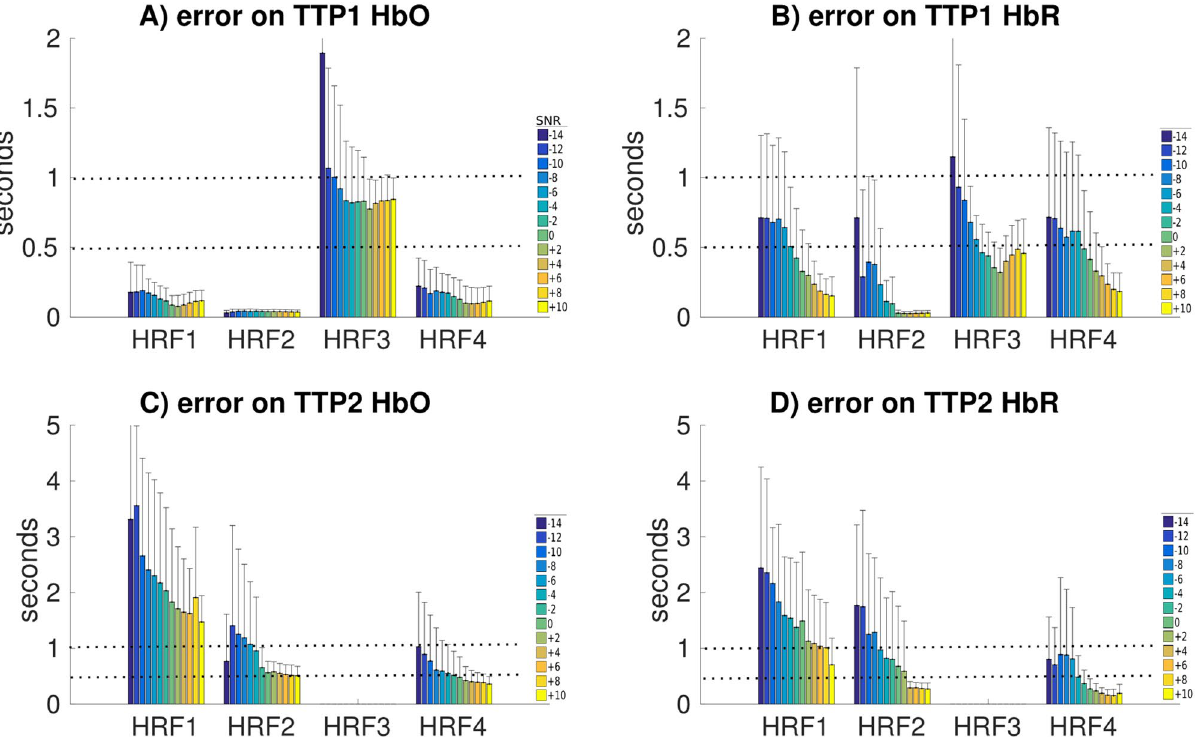
Figure 7. Distributions of the errors in the estimation of TTP as a function of the SNR level for all HRF models. Note that TTP2 for HRF3 was not estimated as no undershoot were simulated.